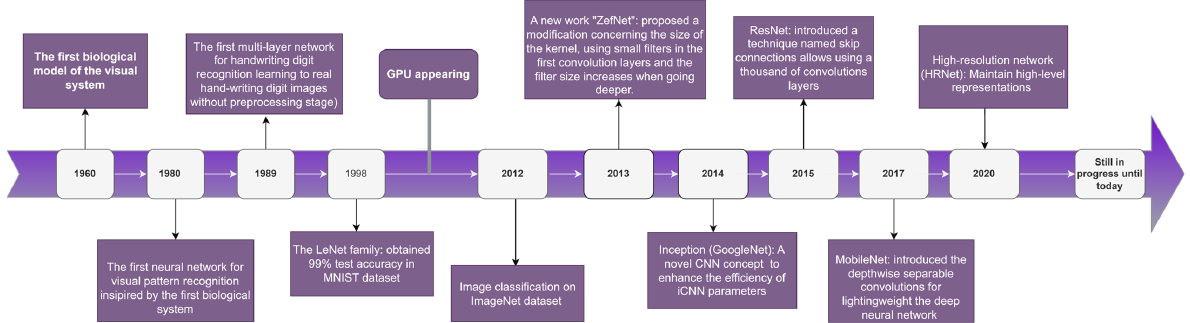
Figure 2. The evolution of CNN over time (Inception [21], ZefNet [22], ResNet [23], MobileNet [24], and HRNet [25]).